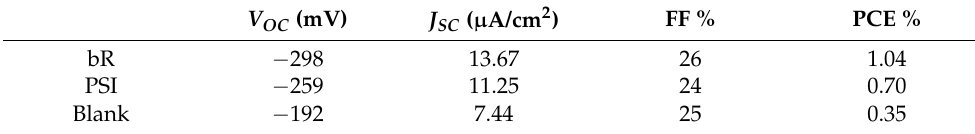
Figure 8. PEDOT/CNT counter electrodes and a gel-based Co II/III electrolyte are also compatible with bR-SSCs. ( A ) J -V curves of different BSSCs illuminated under white irradiance at 100% lamp intensity output. Chronoamperometry measured at 0 V under ( B ) 50% green light and ( C ) 50% red light illumination. Black lines in B and C are blank cells, with green lines showing PSI-SSC data and blue lines showing bR-SSC data. ( D ) Plot showing the spectral irradiance of the LED illumination source at 10% intensity. Table 5. Bio-sensitized solar cells (BSSC) performance using different